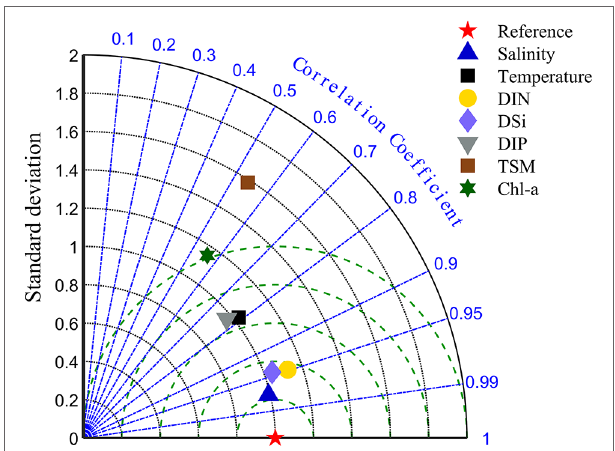
FIGURE 6 | Taylor diagram of simulated and observed data for salinity, temperature, and concentration of DIN, DSi, DIP, TSM, and Chl- a in summer 2015. The radius distance represents the ratio of the standard deviation of the normalized modeling data to the standard deviation of the normalized observed data. Arc is the correlation coefficient between modeling data and observed data. Green dashed line is the ratio of root mean square difference (RMSD) between modeling data and observed